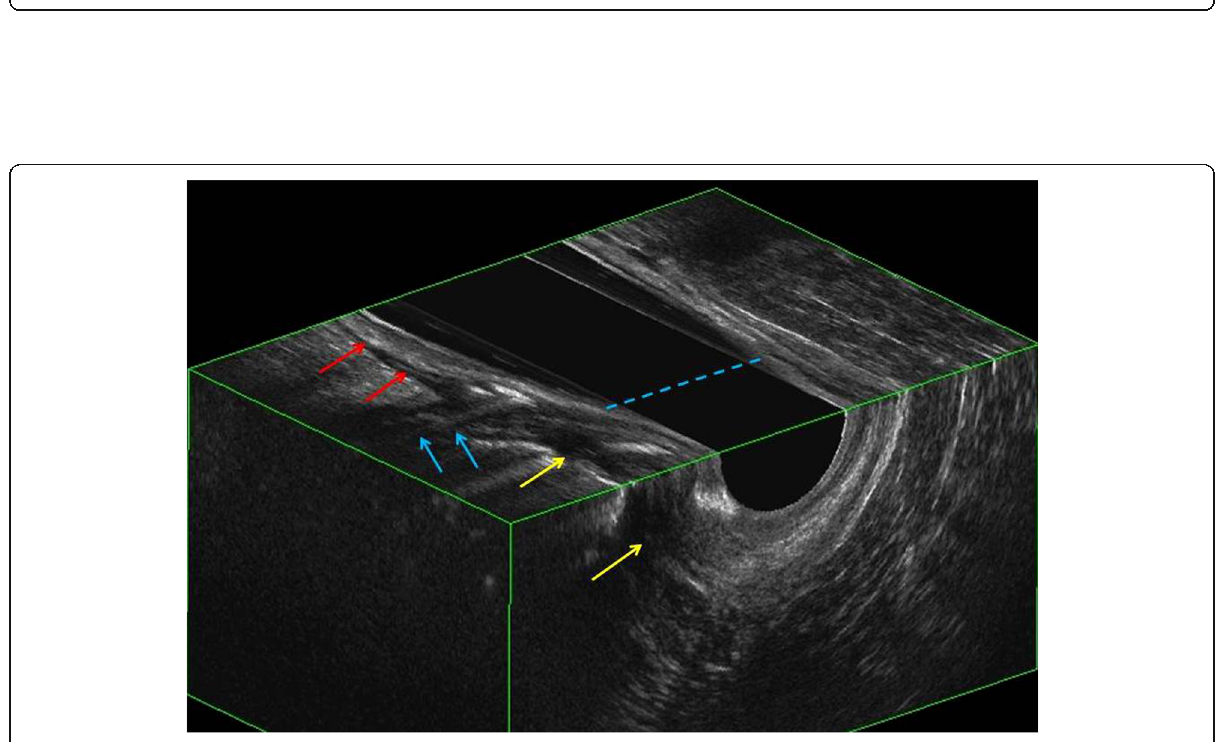
Fig. 12 Section of 3D TRUS image of transsphincteric fistula (yellow arrows) with supralevator extension (red arrows) through the right intersphincteric plane. Blue dotted line marks the level of the anorectal junction and the blue arrows mark the levator